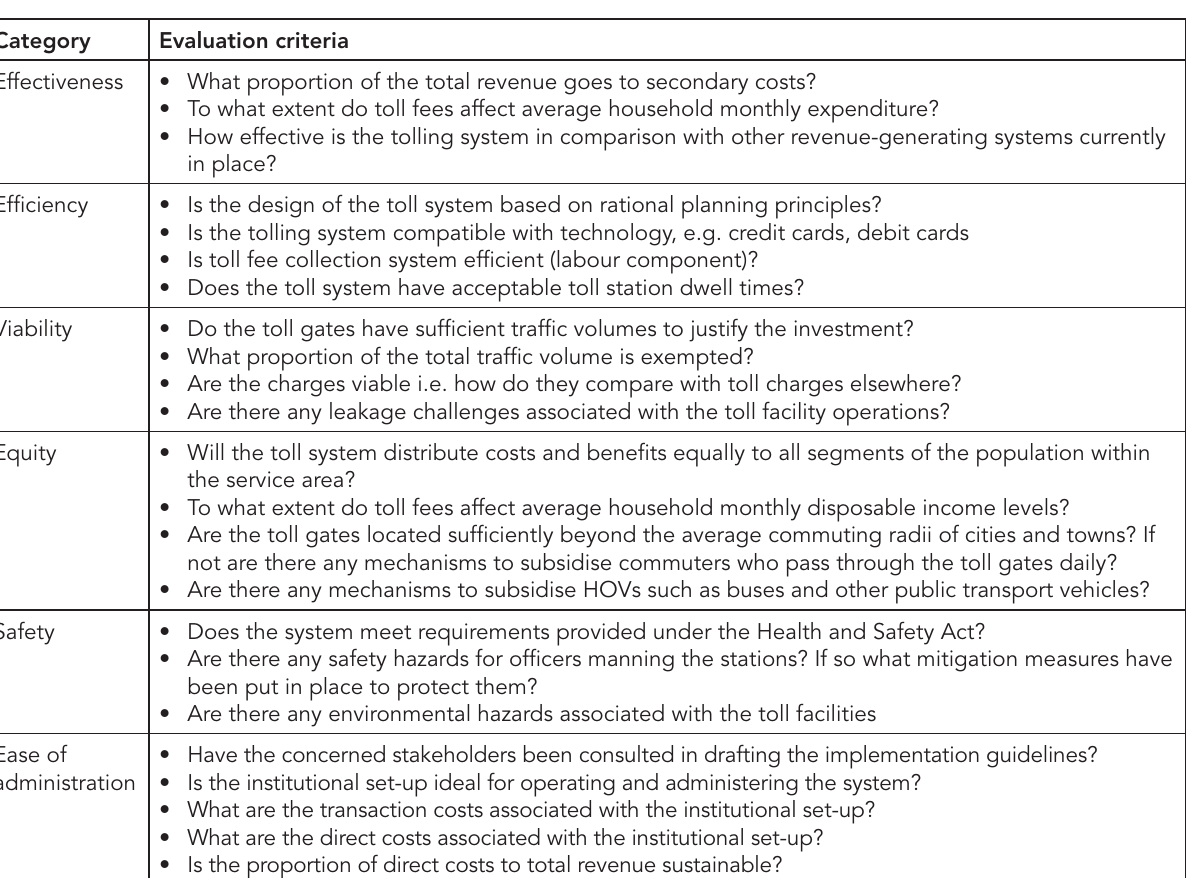
Table I: Criteria used to evaluate the road tolling